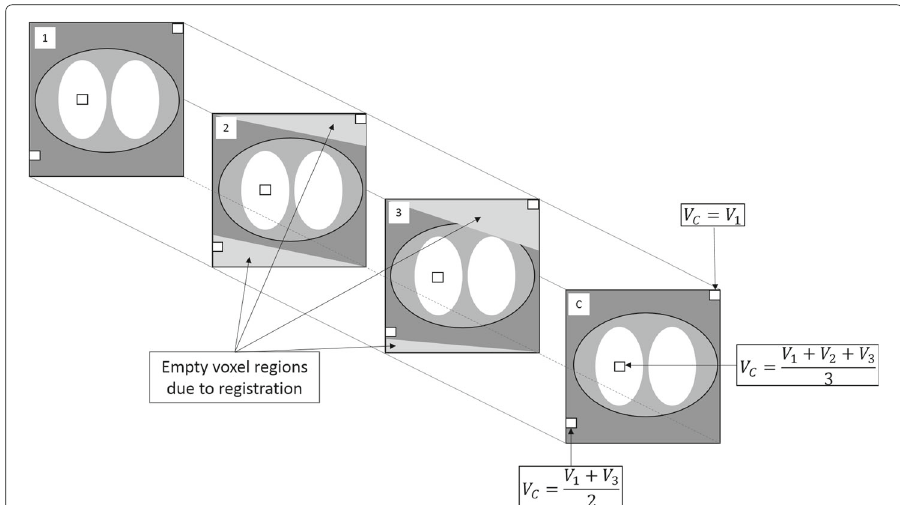
Fig. 1 Schematic of the method to combine the CT data. 1, 2 and 3 represent the CT images from the early, mid and late study sections; C is the resulting combined-CT image; and V is the concentration in the voxel of interest. The white boxes represent specific voxels that are filled in either one, two or all of the CT images after registration. The grey areas at the edges of CT 2 and 3 are the result of